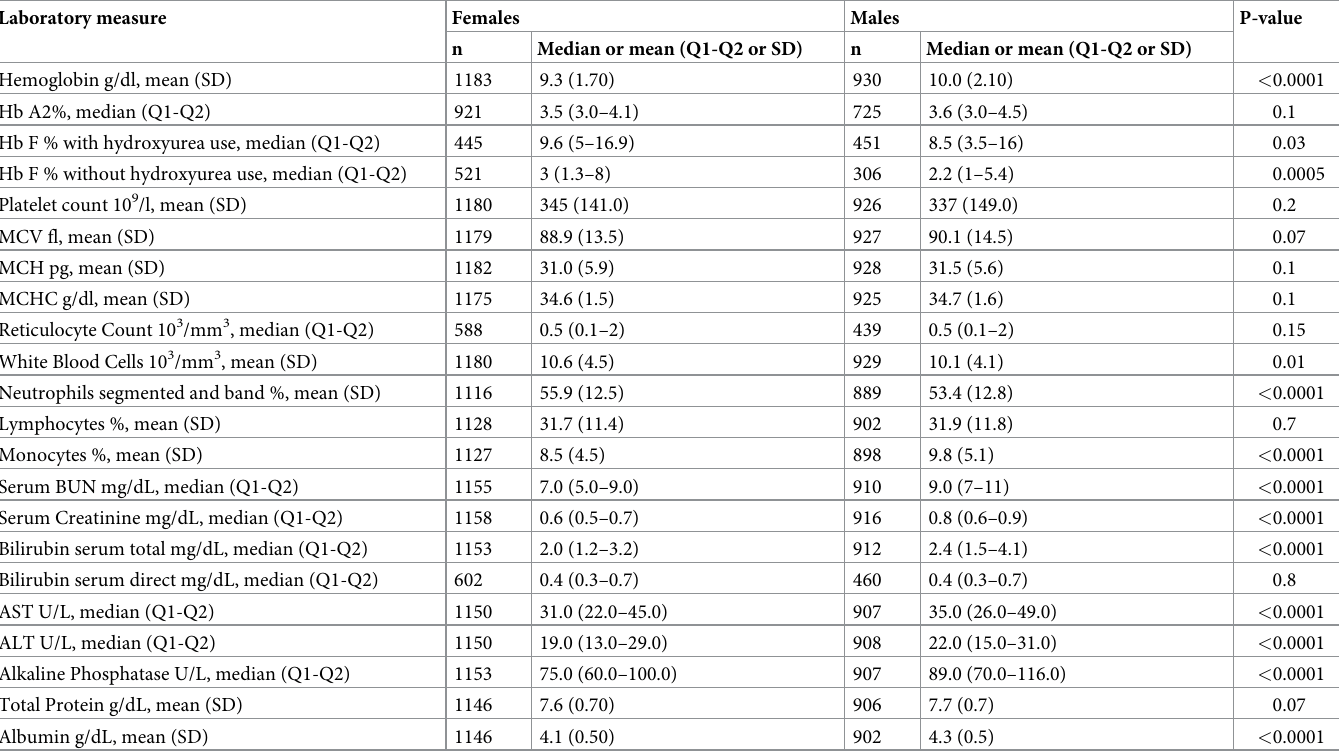
Table 4. Laboratory measures.